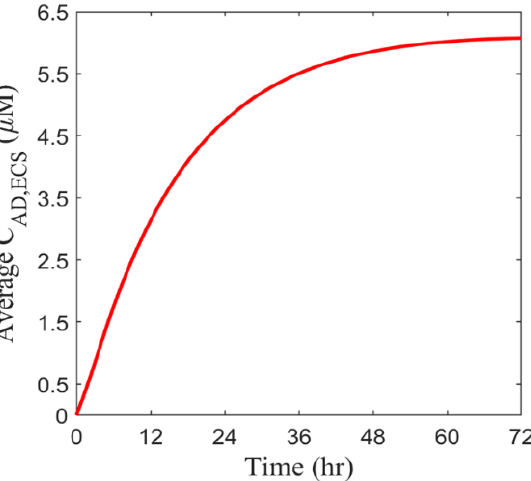
Figure 5. The spatial-averaged concentration of BEV in the brain tumor as a function of time. The spatial distribution of BEV on Day 3 is shown on a vertical plane along the cath- eter track in Figure 6. The BEV concentration achieves its peak at the infusion site and decreases radially towards the domain boundary. Notably, although the infusion is highly directional, as pointed downward in Figure 6, the drugs can still transport along the cath- eter track and accumulate posteriorly at the infusion site. This is related to the drug diffu- sive transport that is determined by the concentration gradient between the infusion site and the tissue. Figure 6. Spatial distribution of BEV on the vertical plane on Day 3. The tumor ’ s biological properties before and after the combination therapy are com- pared on the same vertical plane in Figure 7. Results demonstrate the effectiveness of BEV in reducing the microvasculature surface area in unit tissue ( 𝑆 BL 𝑉 T ⁄ ) and microvascular density ( 𝜖 BL ). The antiangiogenic effect is not limited to the area in front of the catheter. Since BEV can transport deep in the tumor tissue as shown in Figure 6, microvasculature surface area and microvascular density around the catheter can also be reduced. This re- duction can inhibit the drug loss by blood drainage, thereby retaining more drugs within the tumor for treatment. On the other hand, the volume fraction of extracellular space ( 𝜖 ECS ) can consequently be enlarged, which would decrease the tissue resistance to the transport of cytotoxic drugs into the deep tumor region.